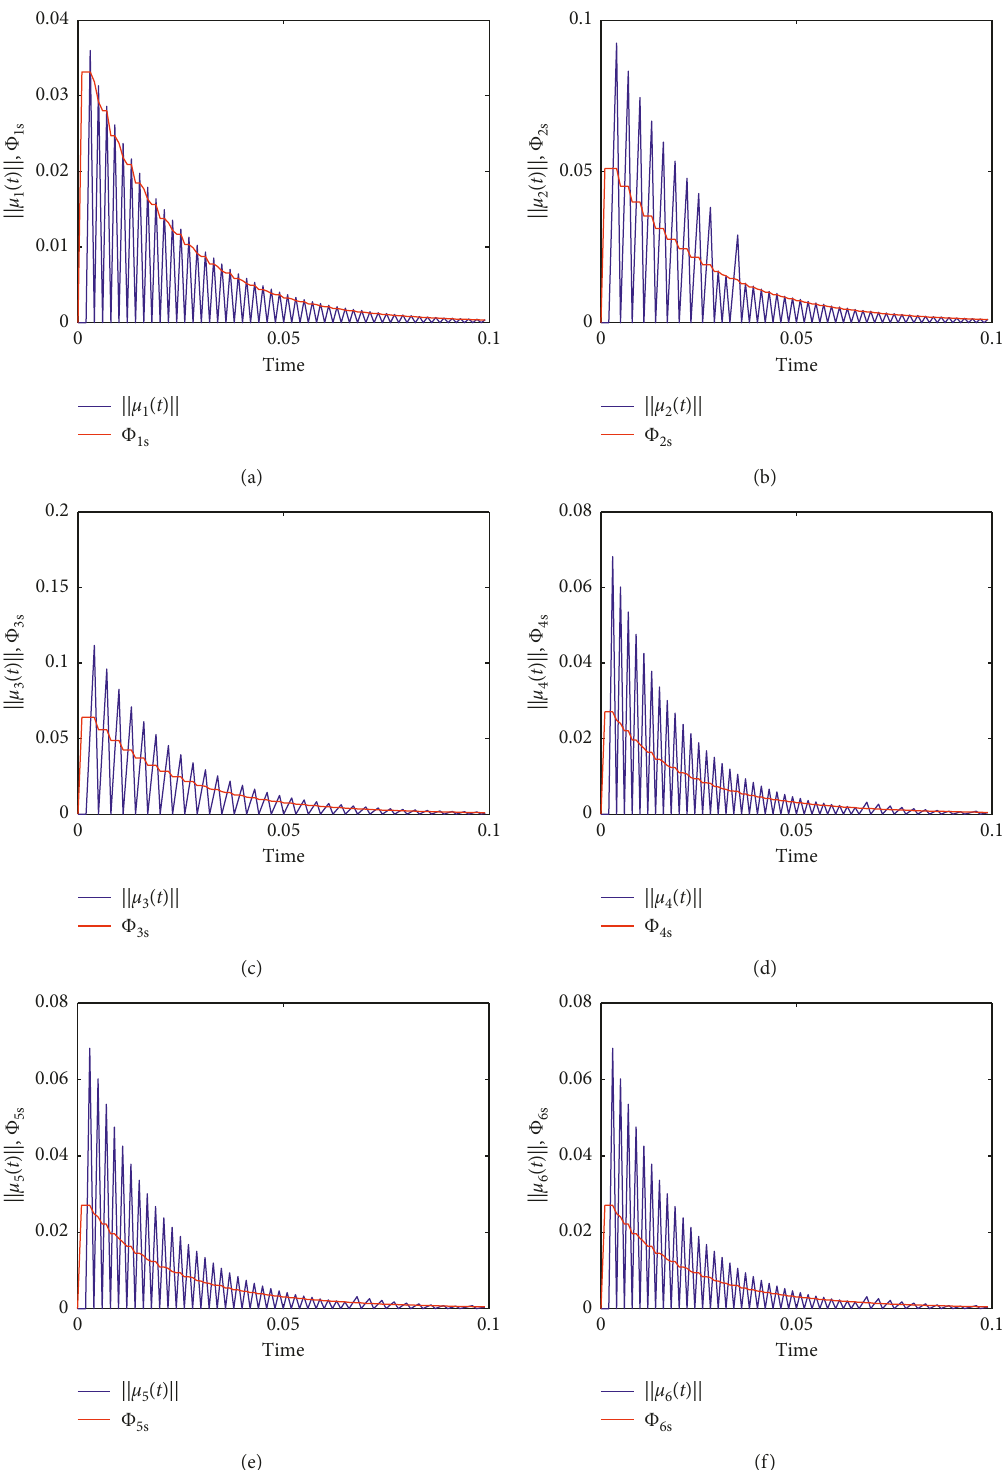
t and the thresholds k ( )